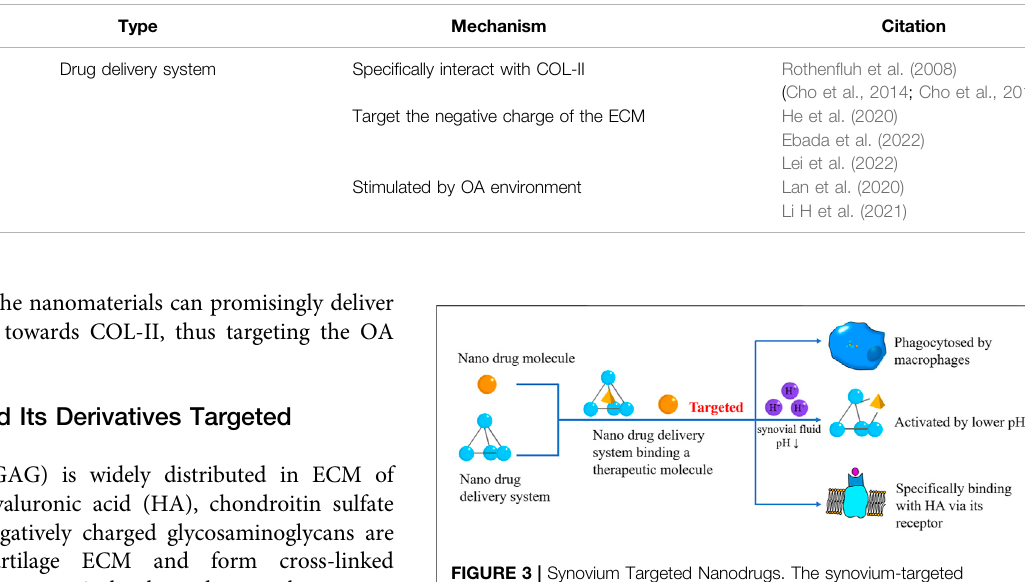
TABLE 2 | ECM targeted